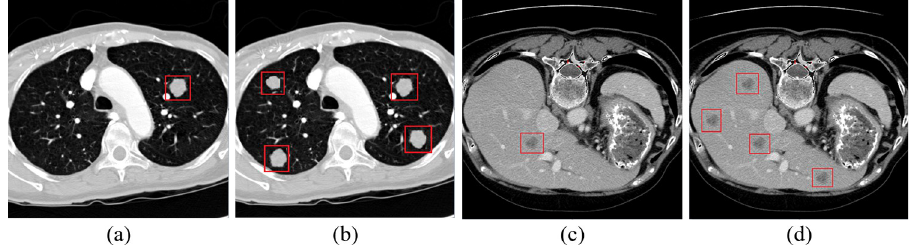
Fig 4. Examples of oversampling. (a) and (c) show the original images of pulmonary nodules, while (b) and (d) show postsampling examples corresponding to images (a) and (c) the sampling rate in these examples was set to 4.